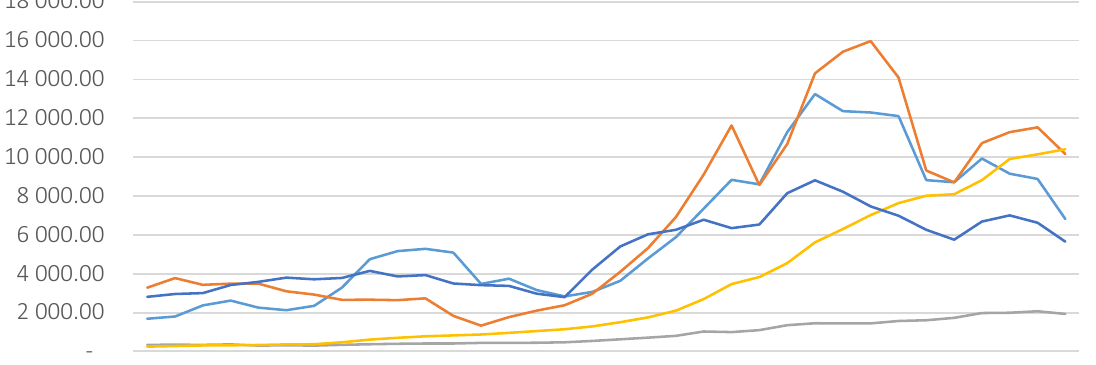
Figure 2. GDP per capita (USD) trends for